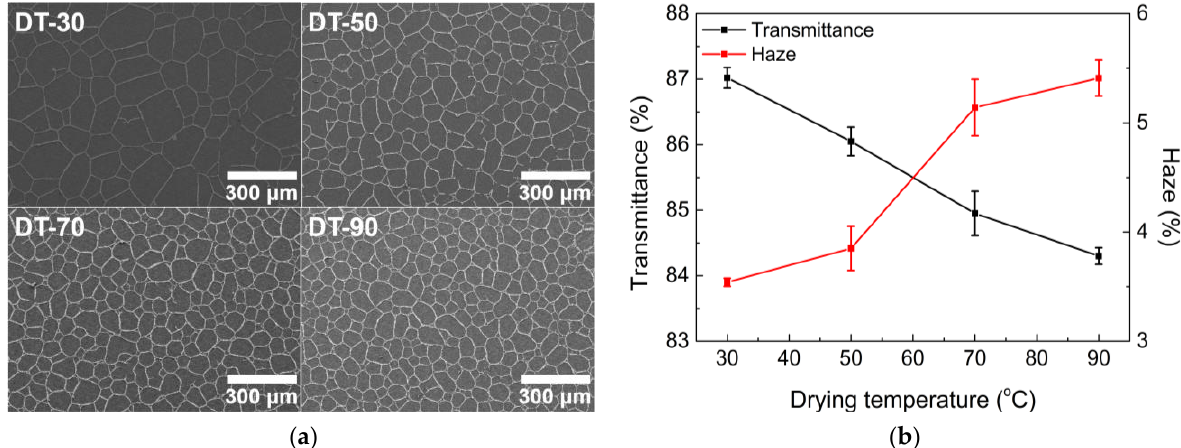
Figure 8. ( a ) SEM images and ( b ) optical properties of TCFs under different drying temperature conditions.